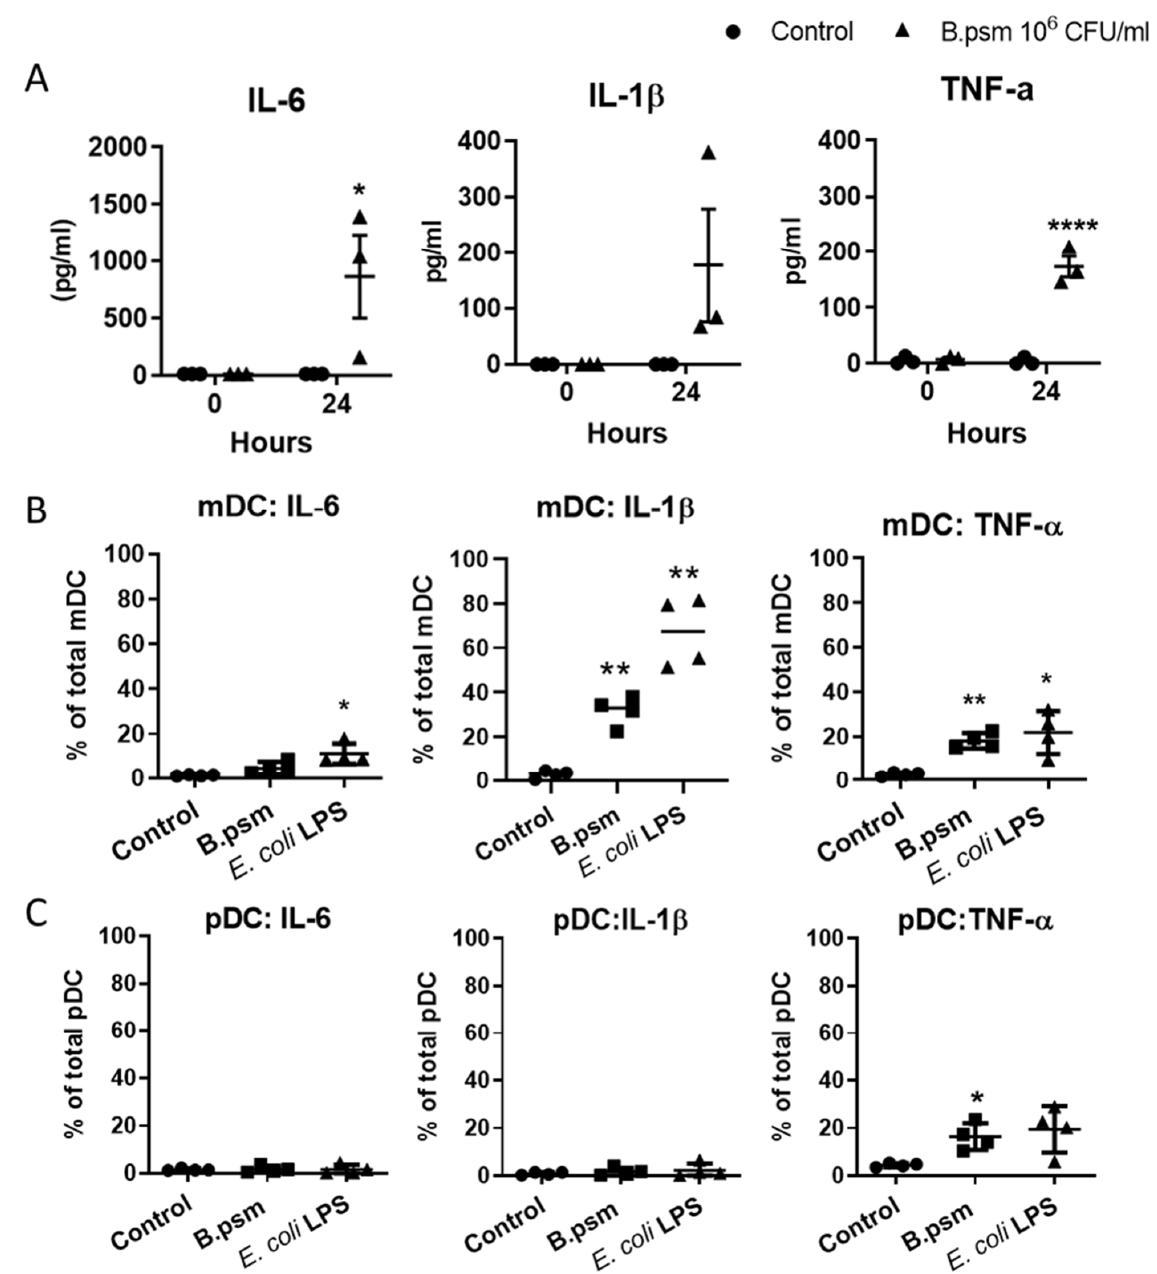
Figure 3. B. pseudomallei induces inflammatory cytokine production by myeloid and plasmacytoid DCs in healthy donors. ( A ) Amounts of secreted TNF- α , IL-1 β and IL-6 in supernatants of enriched DCs following 24-hour stimulation with B.psm or medium only are shown. Percentage of ( B ) mDCs and ( C ) pDCs expressing intracellular IL-6, IL-1 β and TNF- α following 3-hour stimulation with B.psm , E. coli LPS or medium only. MFI of TNF- α in mDCs vs. pDCs after 3-hour stimulation with untreated control, 10 6 CFU/mL B.psm or 100 ng/mL E. coli LPS was also determined. Bars represent mean values ± SEM from three ( A ) or four ( B , C ) independent experiments. A one-way (ANOVA) followed by a Dunnett’s multiple comparisons test was used to compare experimental groups to the medium only control. * p < 0.05, ** p < 0.01, **** p <